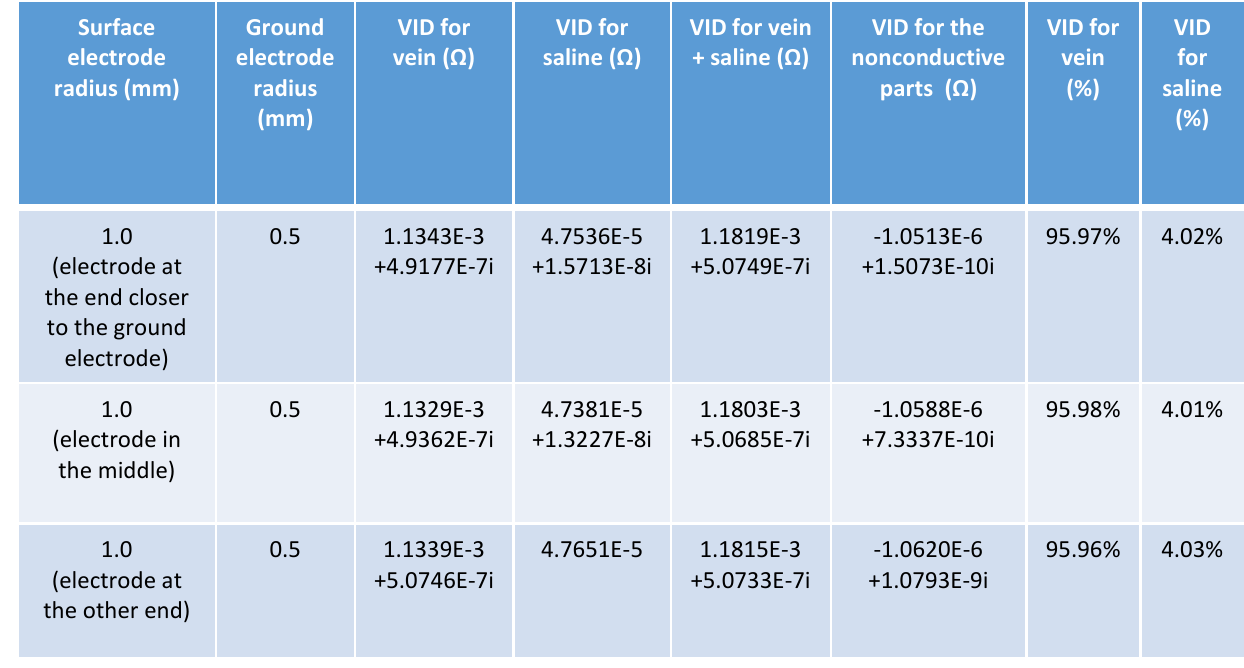
Table.12: Volume integration of Volume Impedance Density (VID) measurements at 1MHz with one of the 32 surface electrodes as terminal (8 electrodes in 4